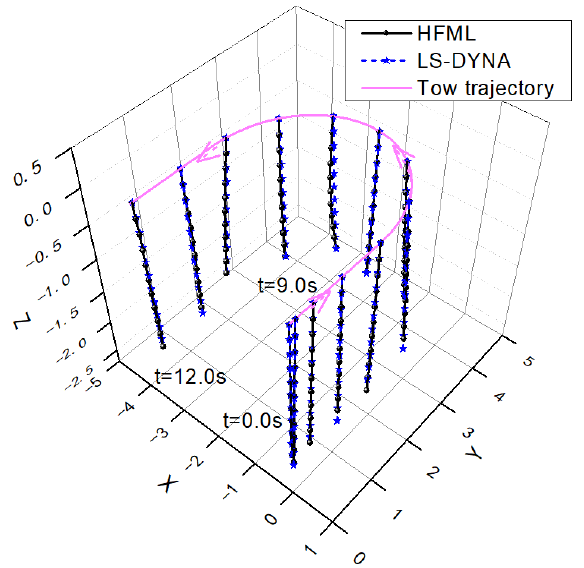
Figure 9. Configuration comparisons for 180 0 U-turn towing process.